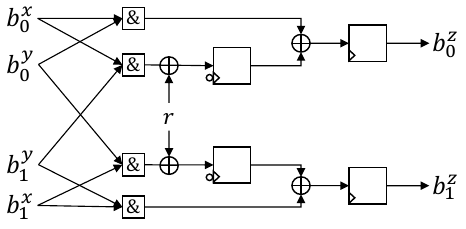
Figure 1: First-order DOM- indep